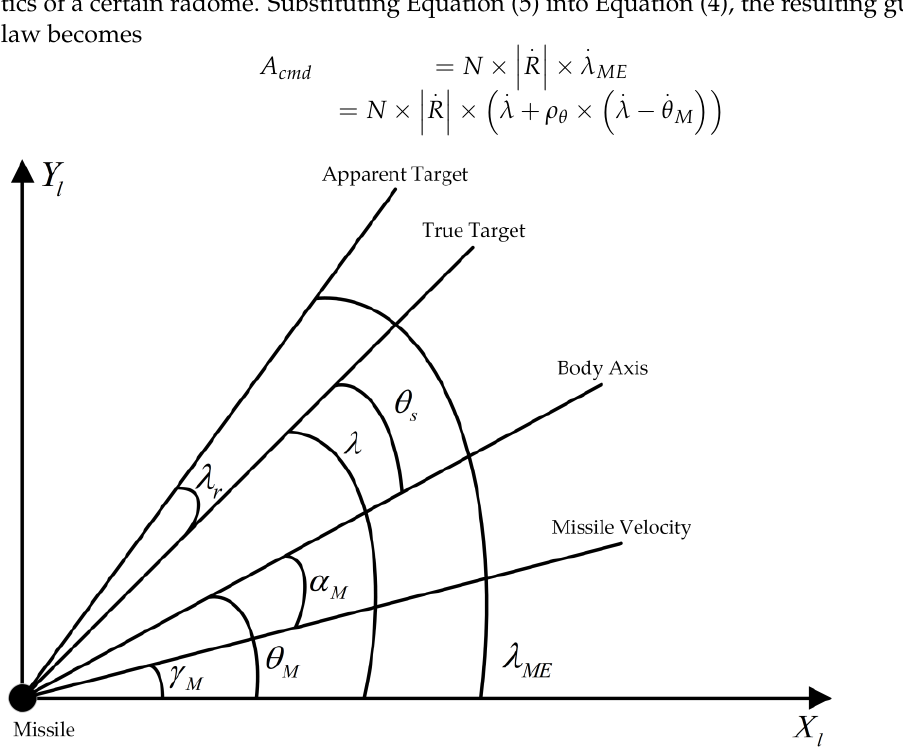
Figure 2. Planar engagement geometry.